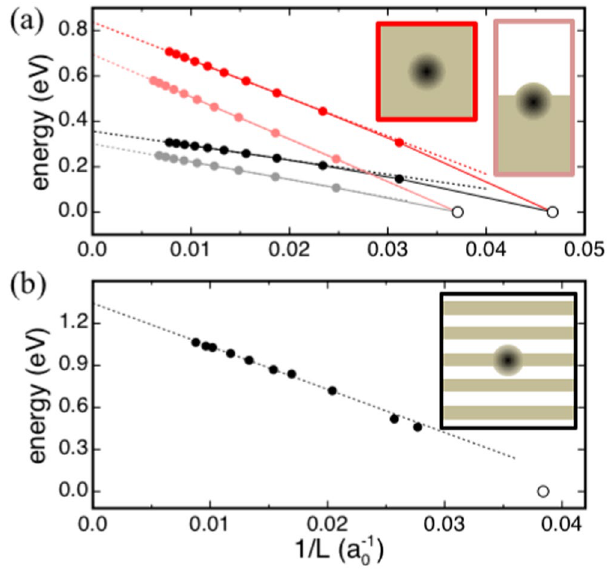
Figure 4. ( a ) Energy vs. L − 1 for a Cl − vacancy defect in (red) rigid and (black) fully polarizable lattice models of (vivid colors) bulk NaCl and (pale colors) the NaCl(001) surface. Supercells of bulk NaCl are cubic, whereas surface models consist of tetragonal supercells with c = 2 a and equal parts of material and vacuum along the c axis. Energy values are refereed to that of a defected supercell with a dimension along the a axis equal to 2 l 0 , 2 antisite defect in orthorhombic model where l 0 is the experimental lattice constant. ( b ) Energy vs. L − 1 for a − B N structures of h-BN. Discs show energy values calculated by using our polarizable energy scheme, and dotted lines show linear interpolations. Insets show schematics of the defected materials